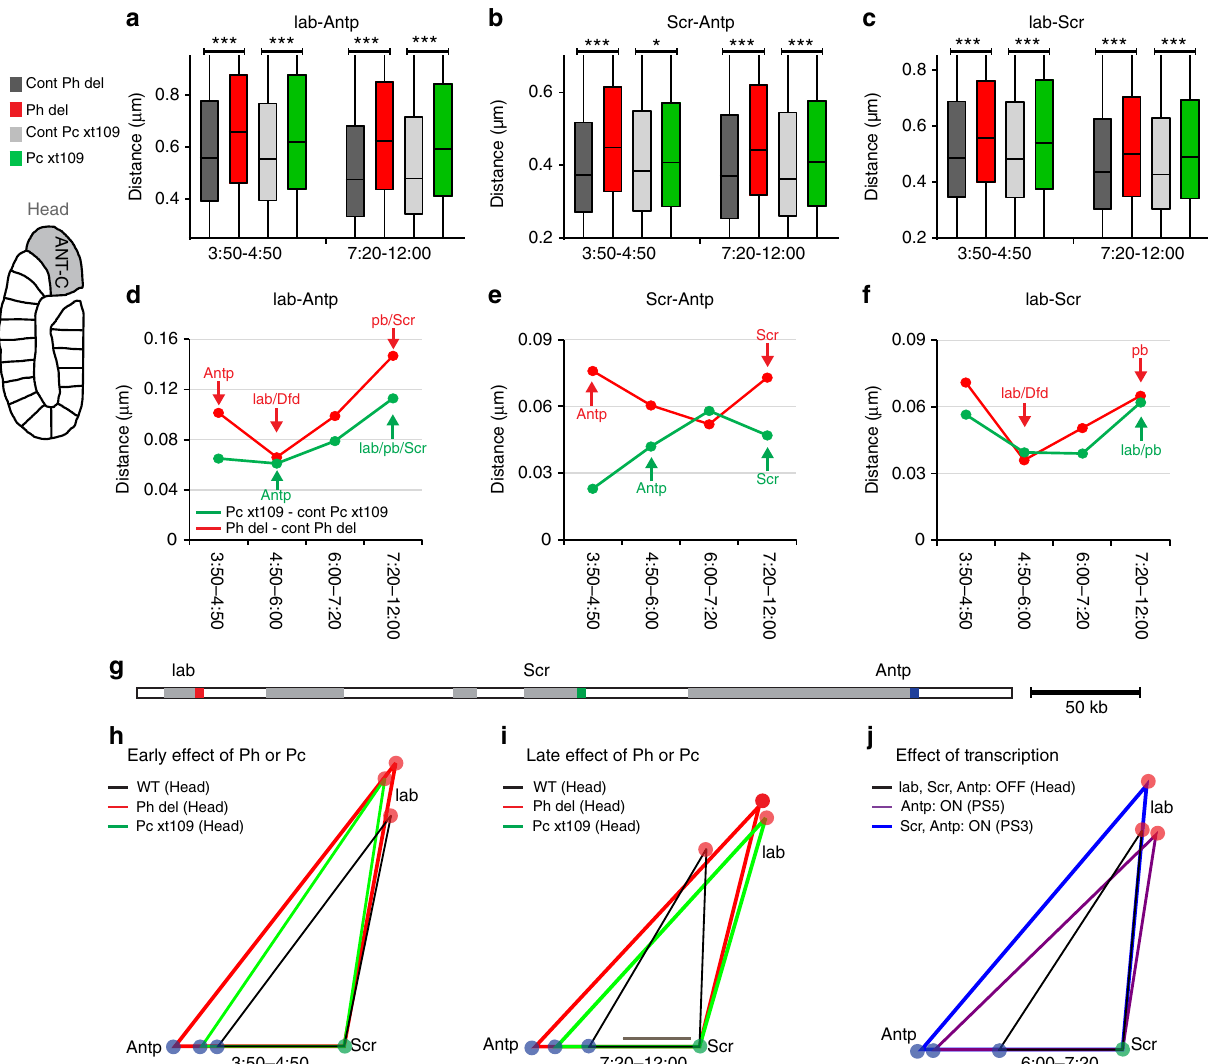
6:00–7:203:50–4:50 7:20–12:00 Fig. 4 Ph and Pc are required to compact repressed ANT-C before ectopic Hox gene transcription. a – c Box plots displaying distributions of the distances: lab – Antp ( a ), Scr – Antp ( b ) and lab – Scr ( c ) in the head during early and late embryogenesis. Distances were measured in the cell nuclei of ph del embryos (red) and their respective controls (dark gray) or Pc XT109 embryos (green) and their respective controls (light gray). Distance distributions are comprised between 0 and 1.5 µ m and the lower and upper bounds of the colored rectangles correspond to the fi rst and third quartiles, whereas the middle bars show the median distances. The black lines indicate signi fi cant differences between the mutants and their respective control embryos (Mann – Whitney U -test, two-tailed, * P < 0.05; ** P < 0.01; *** P < 0.001). d – f Difference between the median distances lab – Antp ( d ), Scr – Antp ( e ), and lab – Scr ( f ) measured in ph del and the same distances measured in its control embryos (red) or in Pc XT109 and its control embryos (green) during embryonic development in head. Arrows indicate when a Hox gene is fi rstly ectopically expressed in ph del (red) or Pc XT109 (green) embryos. g Schematic linear representation of ANT-C showing the DNA FISH probe positions. h – j Plots of the three median distances corrected for chromatic aberrations, between the promoters of lab , Scr , and Antp . Comparison of the effects of Ph and Pc on the folding of ANT-C inside cell nuclei during early ( h ) and late embryogenesis ( i ) with the openings induced by Hox gene transcription ( j ). Scale bar, 100 second post- fi xation step was then performed with PBT + 5% formaldehyde for 25min. After being washed in PBT, embryos were transferred to a hybridization solution (50% formamide, 5 ×SSC, 100 µg/ml tRNA, 50µg/ml heparin, and 0.1% Tween), and pre-hybridization was performed for 1h at 55°C. Finally, embryos were hybridized for 16 – 20 h at 55 °C with labeled probes followed by extensive washes. Typically, we added 1.2µl of three probes containing either A488, A555, or A647 to 50µl of hybridization buffer. DAPI staining was performed before mounting the embryos in Vectashield (Eurobio, H-1000) between a slide and coverslip. RNA FISH experiments were performed on embryos collected from Oregon-R w 1118 , ph del /FKG, or Pc XT109 /TKG fl ies. Ectopic Hox gene expression was never observed in Oregon-R w 1118 embryos, whereas ~25% of the embryos issued from Ph del /FKG crosses showed ectopic expression of Ubx or Antp from developmental stage 9 through later embryogenesis and corresponded to ph del mutant embryos. Similarly, ~25% of the embryos issued from Pc XT109 /TKG crosses showed ectopic